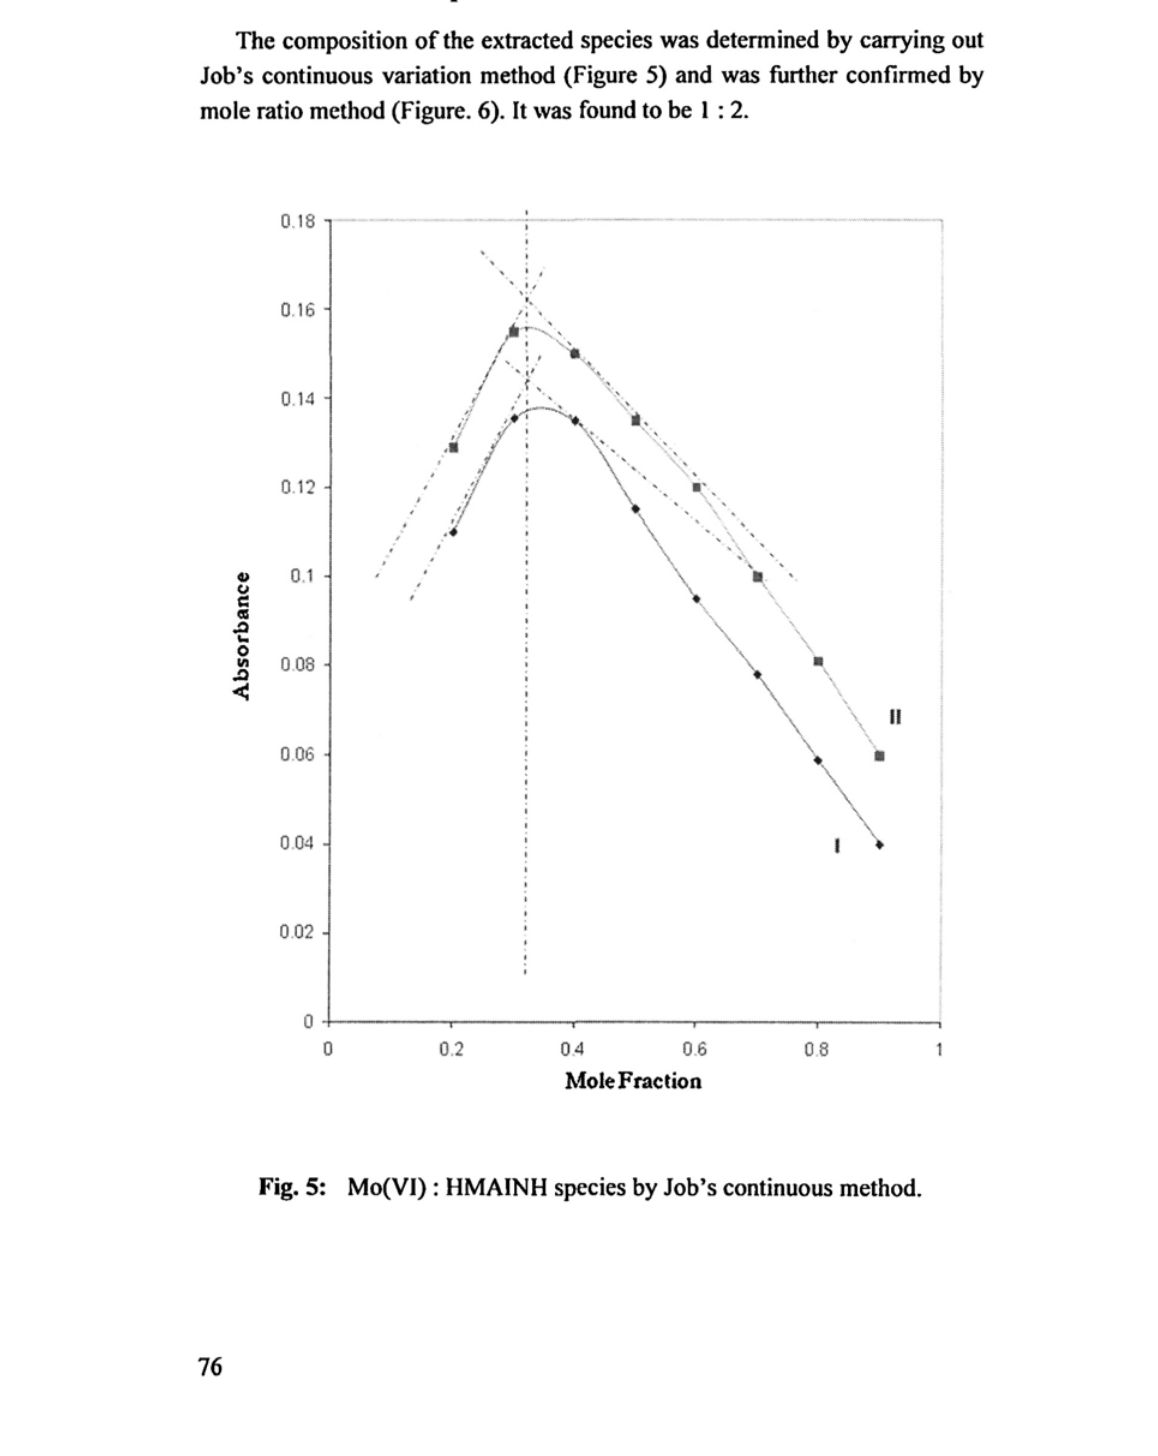
Fig. 5: Mo(VI) : HMAINH species by Job's continuous